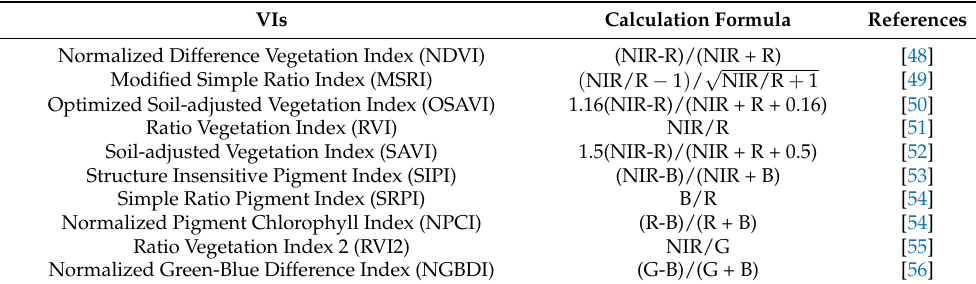
Table 2. The selected VIs and their calculation formulas.